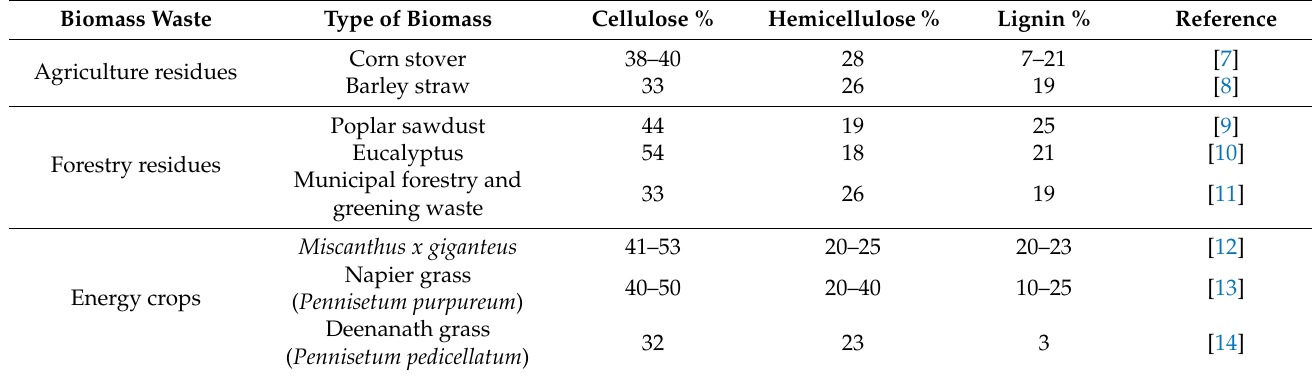
Table 1. Chemical composition of diverse biomass